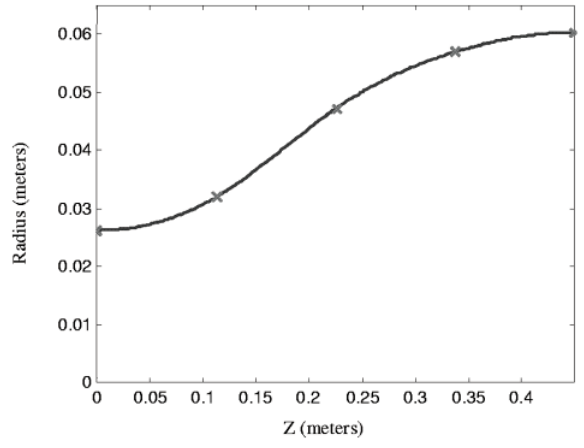
FIG. 16. Arc taper profile.